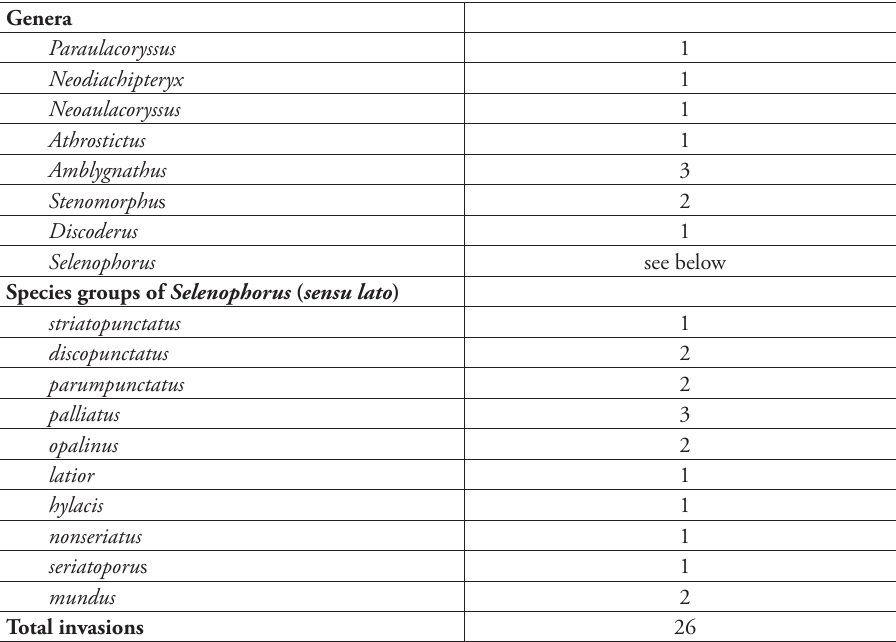
Table 5. Minimum number of postulated invasions of the West Indies by the Selenophori. Genera